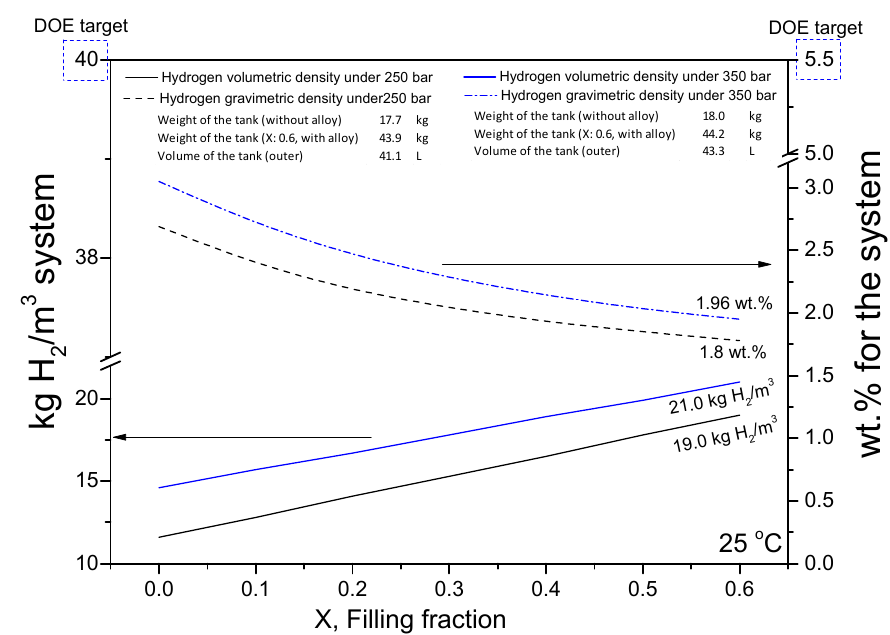
Figure 9. Curves of the hydrogen volumetric and gravimetric capacity of the hybrid tank as a function of the degree of filling of the alloy.